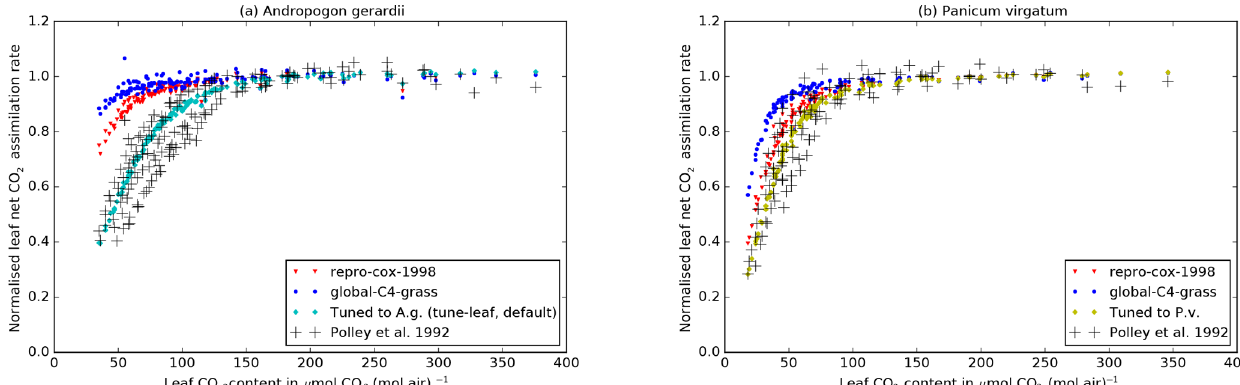
Figure 5. Black crosses: A l – c i curves for Andropogon gerardii (left) and Panicum virgatum (right) from FIFE_PHO_LEAF_46 (Polley et al., 1992), normalised by the mean A l of the data points with c i > 150µmolCO 2 (molair) − 1 in that curve. Only curves with mean incident PAR greater than 1200µmolPARm − 2 s − 1 have been used. Coloured points: normalised A l calculated from observed c i and incident PAR for each data point in the curve and the mean T leaf observation for each curve, using the JULES relations. The JULES parameters are taken from the repro-cox-1998 configuration (red triangles), the global-C4-grass configuration (blue circles) and fits to A. g. data ( tune-leaf default configuration; cyan diamonds) and P. v. data (yellow diamonds). Model points have been calculated using the Leaf Simulator package.